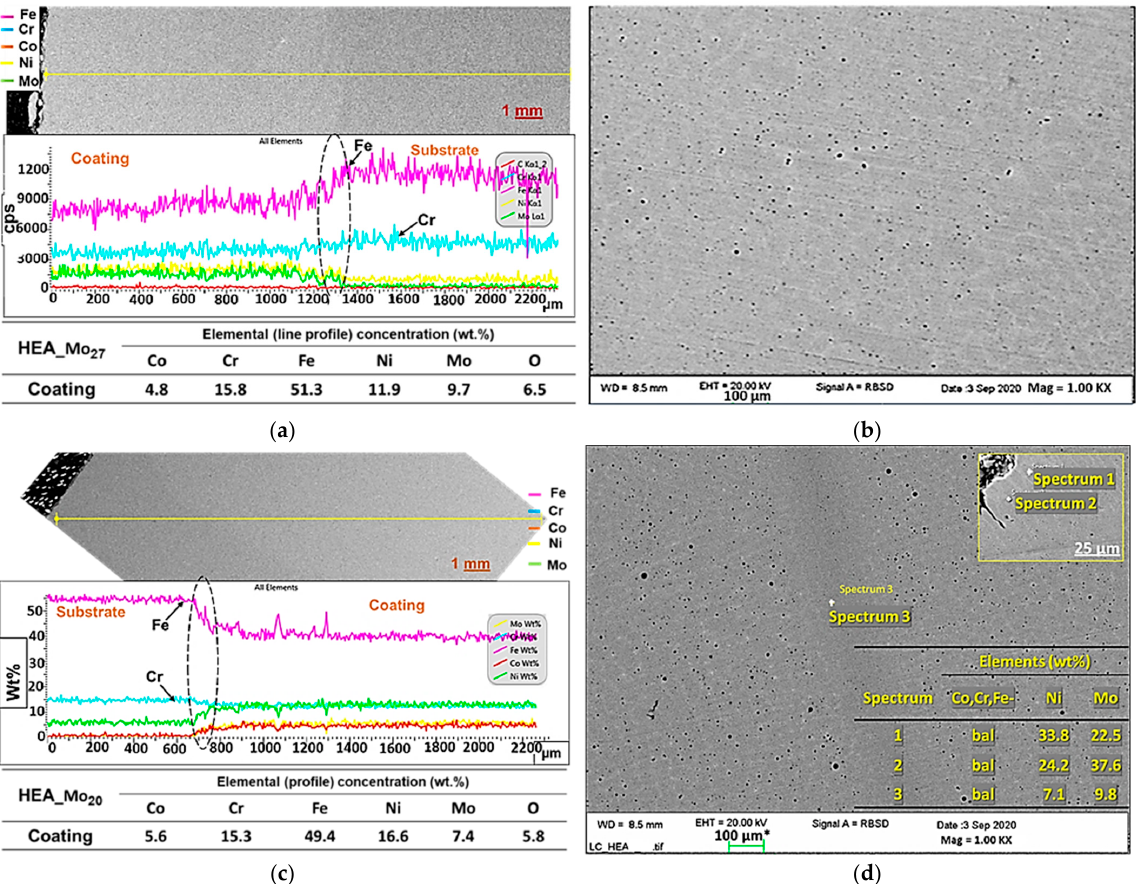
Figure 6. SEM and BSE micrographs of the cross-sections, and EDX line scans, point and area anal- ysis of the as-sprayed ( a , b ) LC-HEA_Mo 27 and ( c , d ) LC-HEA_Mo 20 coatings. of the as-sprayed ( a , b ) LC-HEA_Mo 27 and ( c , d ) LC-HEA_Mo 20